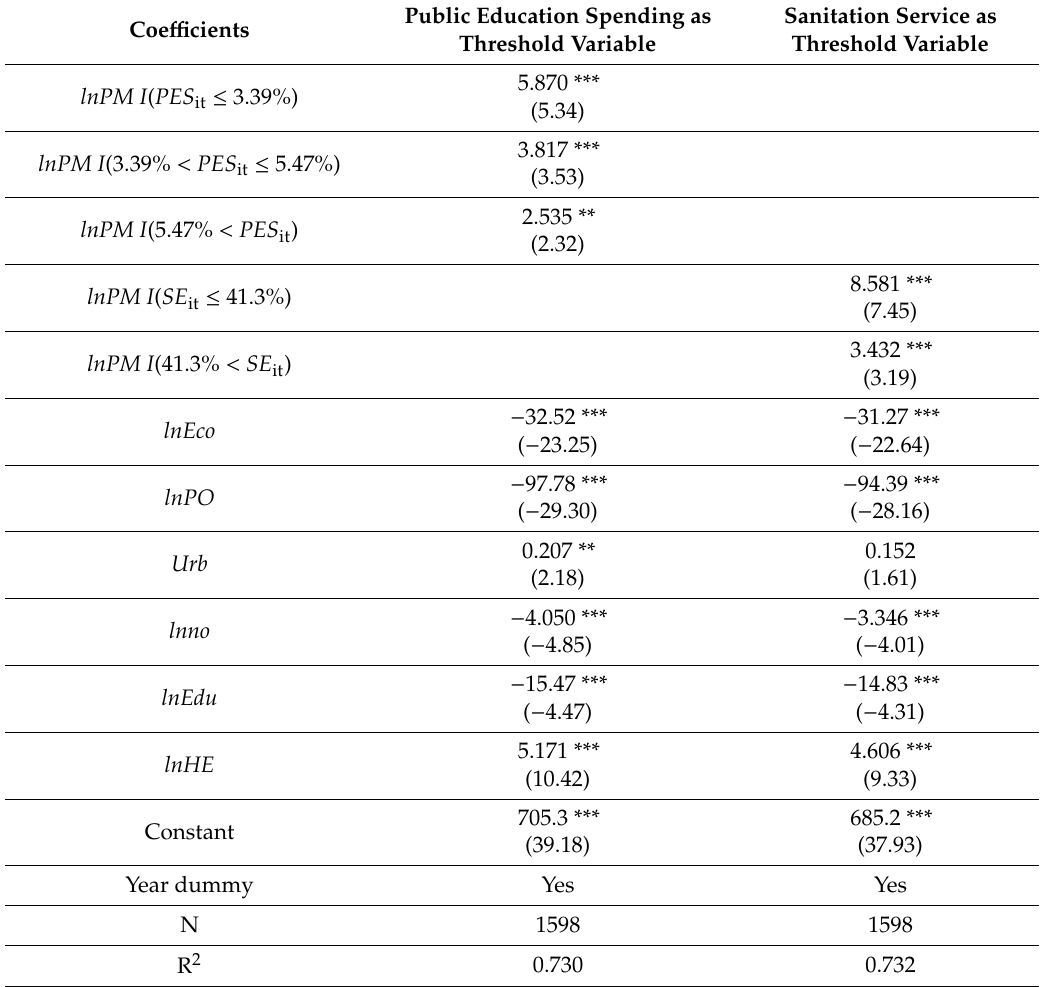
Table 10. Threshold regression estimation